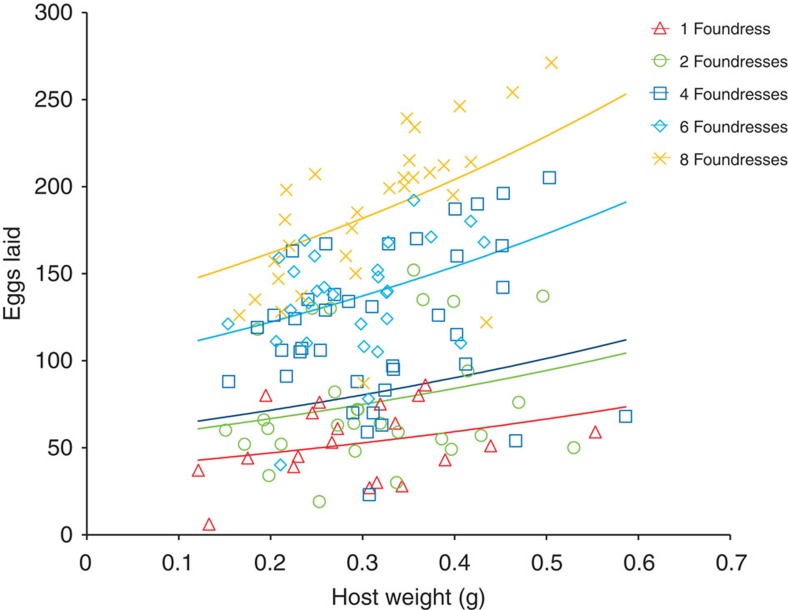
Number of eggs laid on hosts in relation to host size and foundress number.Larger clutches of eggs were laid on heavier hosts and, additively, by larger numbers of foundresses (log-linear ANCOVA: host weight, F1,140=15.6, P<0.001; foundresses, F4,141=50.64, P<0.001; interaction, F4,136=0.45, P=0.773). The fitted regression lines are: number of eggs=exp (1.156 × host weight+constant), with the constants for 1, 2, 4, 6 and 8 foundresses as 3.62, 3.97, 4.04, 4.575 and 4.856, respectively. Sample sizes for 1, 2, 4, 6 and 8 foundresses were 20, 29, 39, 28 and 30, respectively.